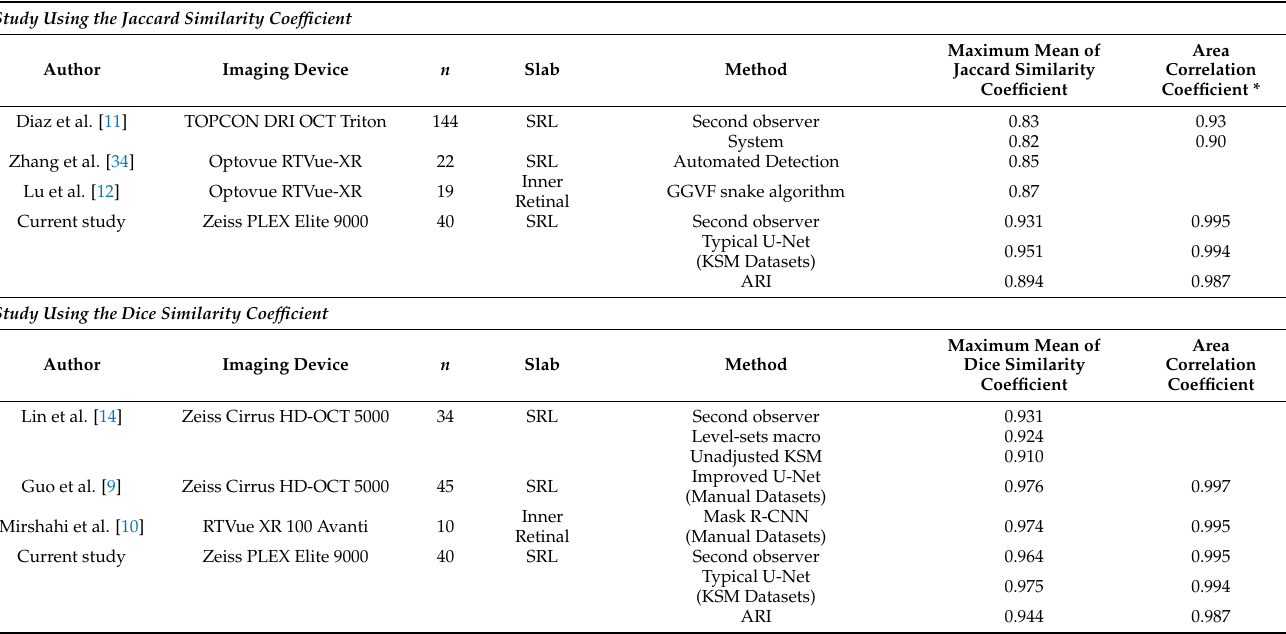
Table 5. Previous studies using the Jaccard index and DSC, and the maximum average of each